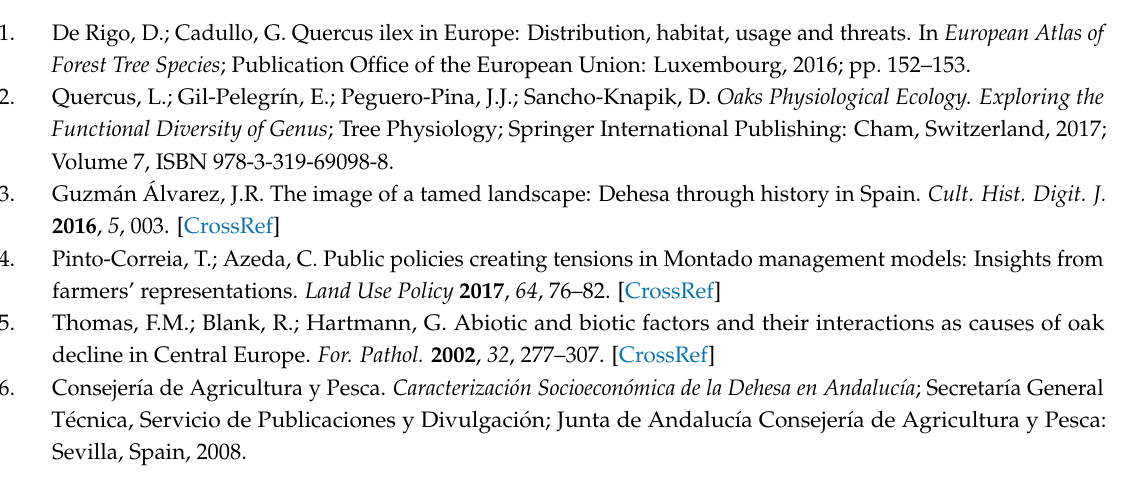
Table S1: Means of all the studied variables with standard error at 30 dpi, Table S2: Statistics of Repeated Measures